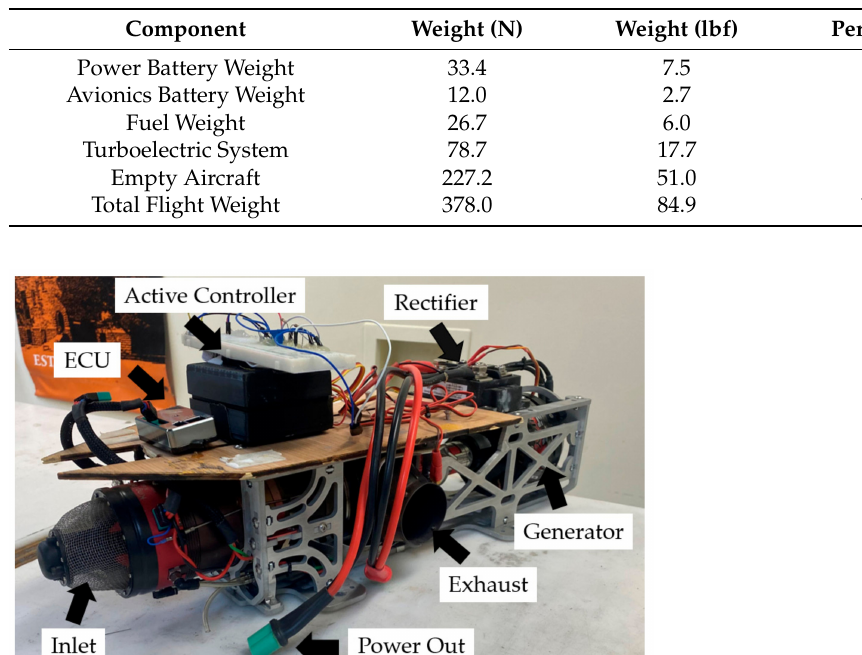
Table 2. Turboelectric Aircraft Weight Breakdown.